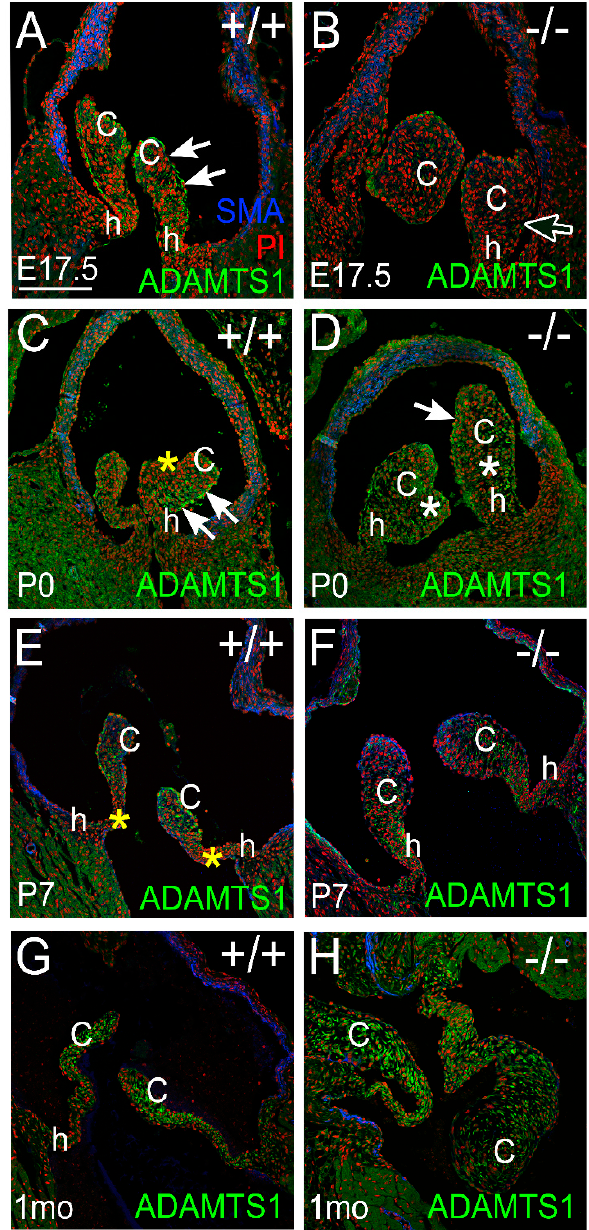
Figure 3. ADAMTS1 localization is evident in a subset of valve ECM and is increased after birth in the Adamts5 − / − pulmonary valve. ADAMTS1 immunolocalization (green) at embryonic day 17.5 (E17.5; A , B ), postnatal day 0 (P0; C , D ), postnatal day 7 (P7; E , F ) and 1 month of age (1 mo; G , H ) in wild type PV (+/+; A , C , E , G ) and Adamts5 − / − PV ( − / − ; B , D , F , H ). c—valve cusp; h—valve hinge region. White asterisk ( D ), increased localization in cusp; white outline arrow ( B )—loss of ADAMTS1 in the endocardium; Red—propidium iodide; Blue— α SMA (used as a marker of smooth muscle cells in the arterial wall.) Solid white arrows—endocardial expression of ADAMTS1; yellow asterisk—layer of cusp devoid of ADAMTS1 localization. Bar in ( A ) = 150 μ m and applies to ( B – H ).